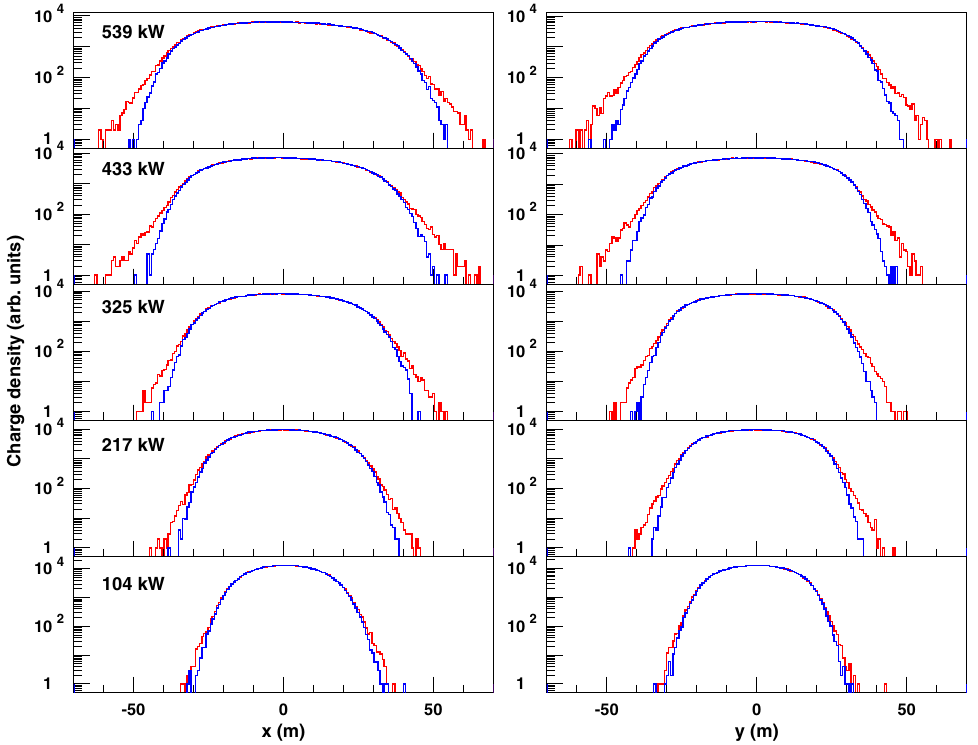
FIG. 17. Transverse beam profiles at the end of injection calculated with (red) and without (blue) the dipole field ripple for various beam intensities from 104 to 539